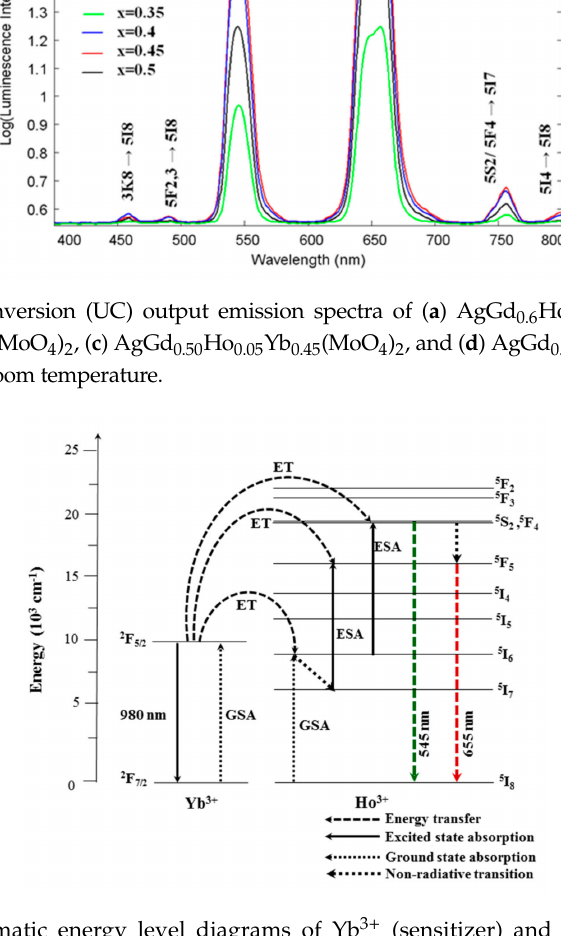
Figure 6. The schematic energy level diagrams of Yb 3 + (sensitizer) and Ho 3 + (activator) ions in the AgGd 0.95 − y Ho 0.05 Yb y (MoO 4 ) 2 system and the upconversion mechanisms of the green and red emissions under 980 nm laser excitation: ET (energy transfer), ESA (Excited state absorption), GSA (Ground state